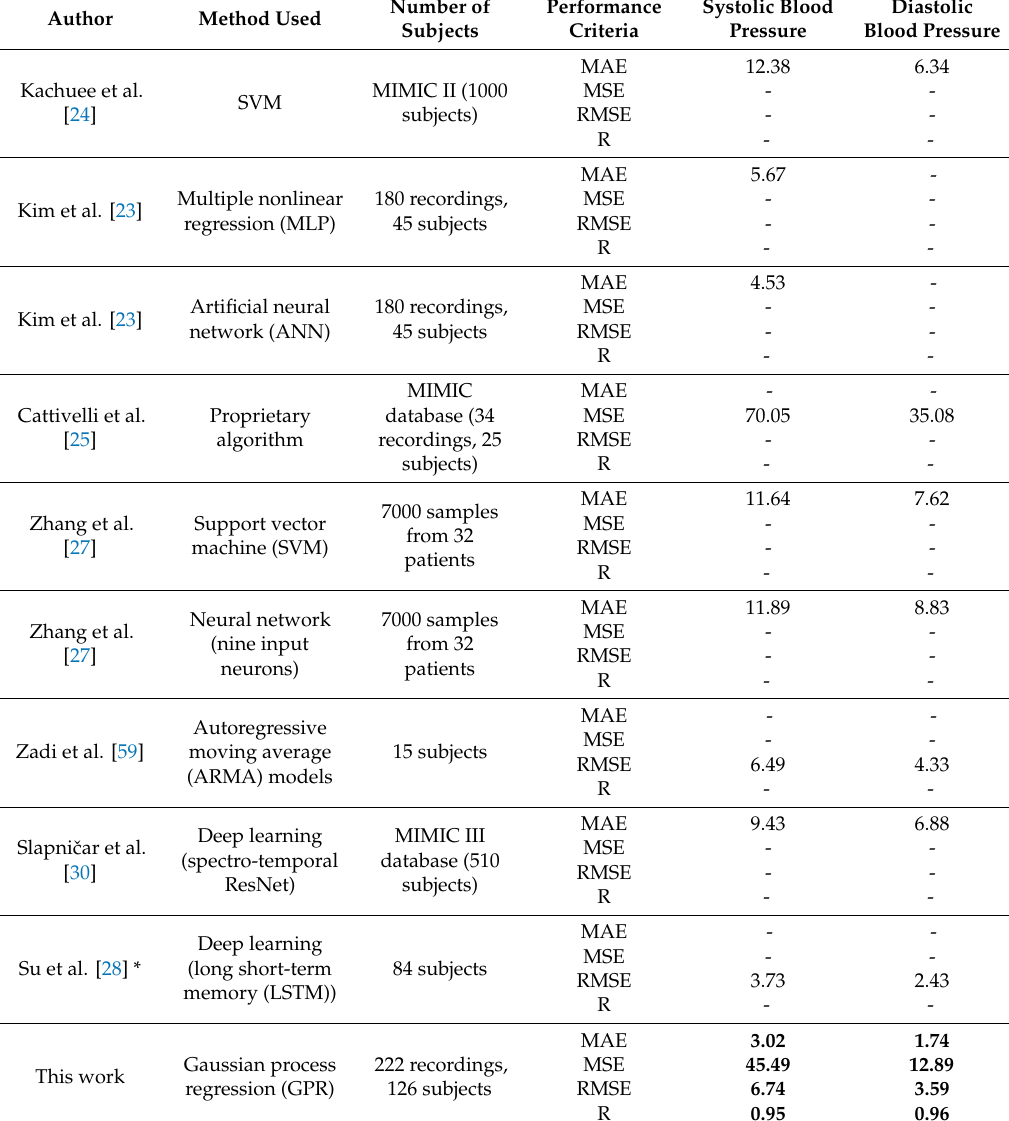
Table 12. Comparison with related works in relation to dataset, methodology, and estimation